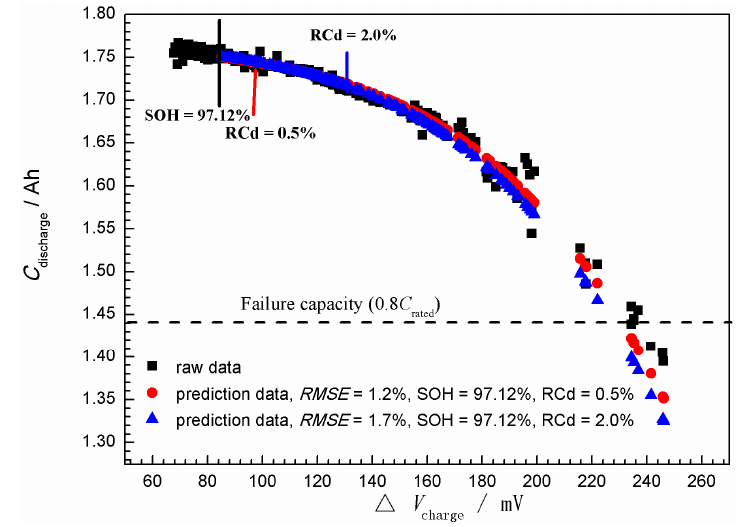
Figure 6. ( C discharge , ∆ V charge ) raw data used in Figure 5 and the prediction data with the best RMSE (1.2%) and the RMSE (1.7%) near the RMSE in Figure 5 (1.75%).